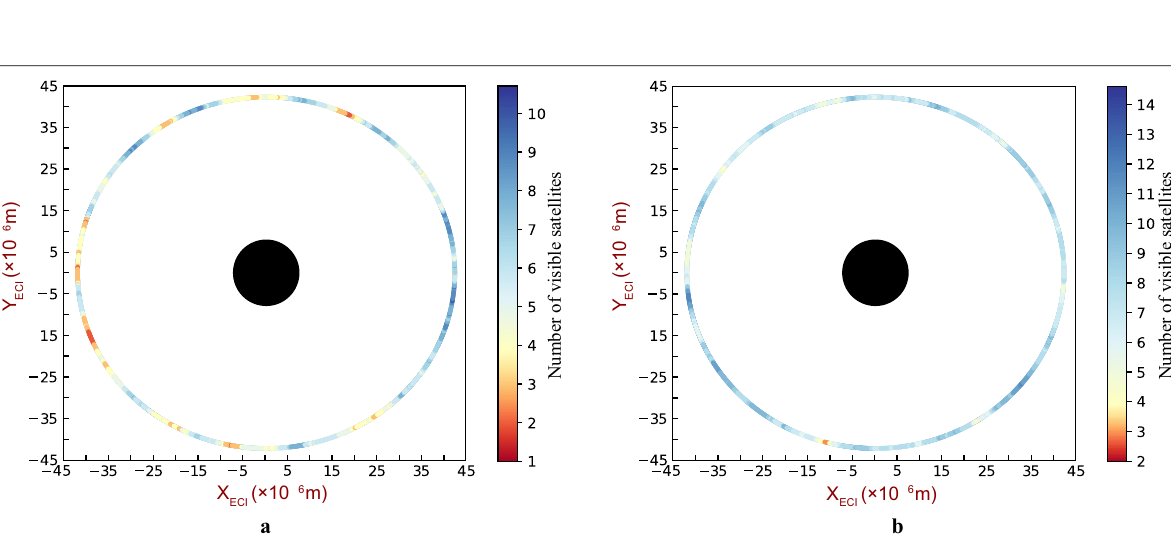
Fig. 5 The number of visible satellites of the spacecraft in GEO (0°) under different combinations: a BDS; b GPS GPS Galileo GLONASS BDS (only MEO satellites); d GPS + + +